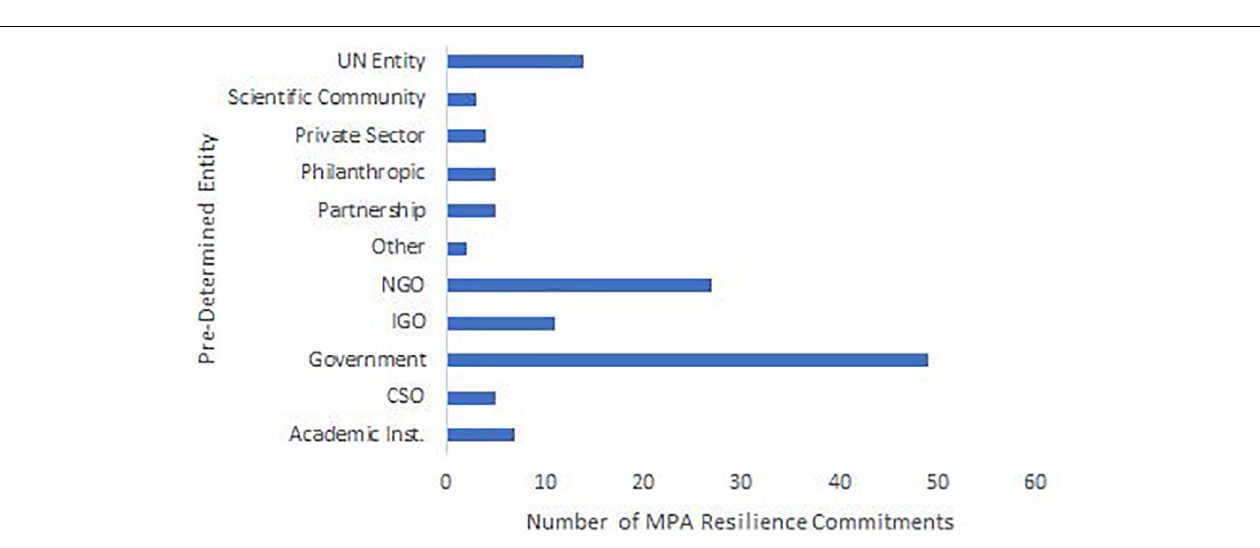
FIGURE 5 | Resilience MPA commitments according to entity. Each commitment description under SDG 14.5 was read for references toward resilience. Data were collected in September 2017. N =